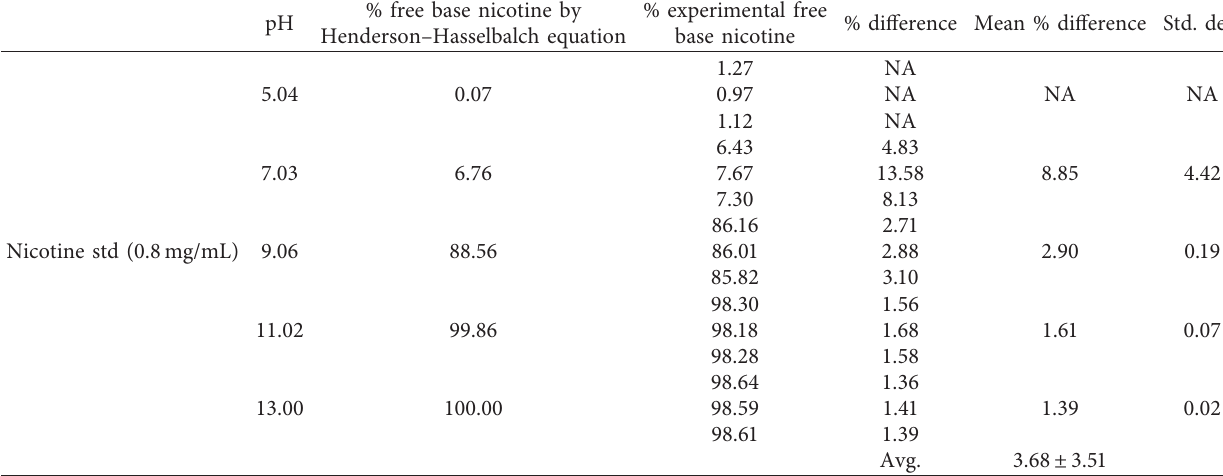
Table 3: Determination of free base nicotine in standard solutions by toluene-water double extraction.